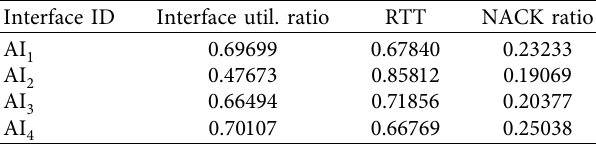
Table 3: Normalized decision matrix for interface alternatives.